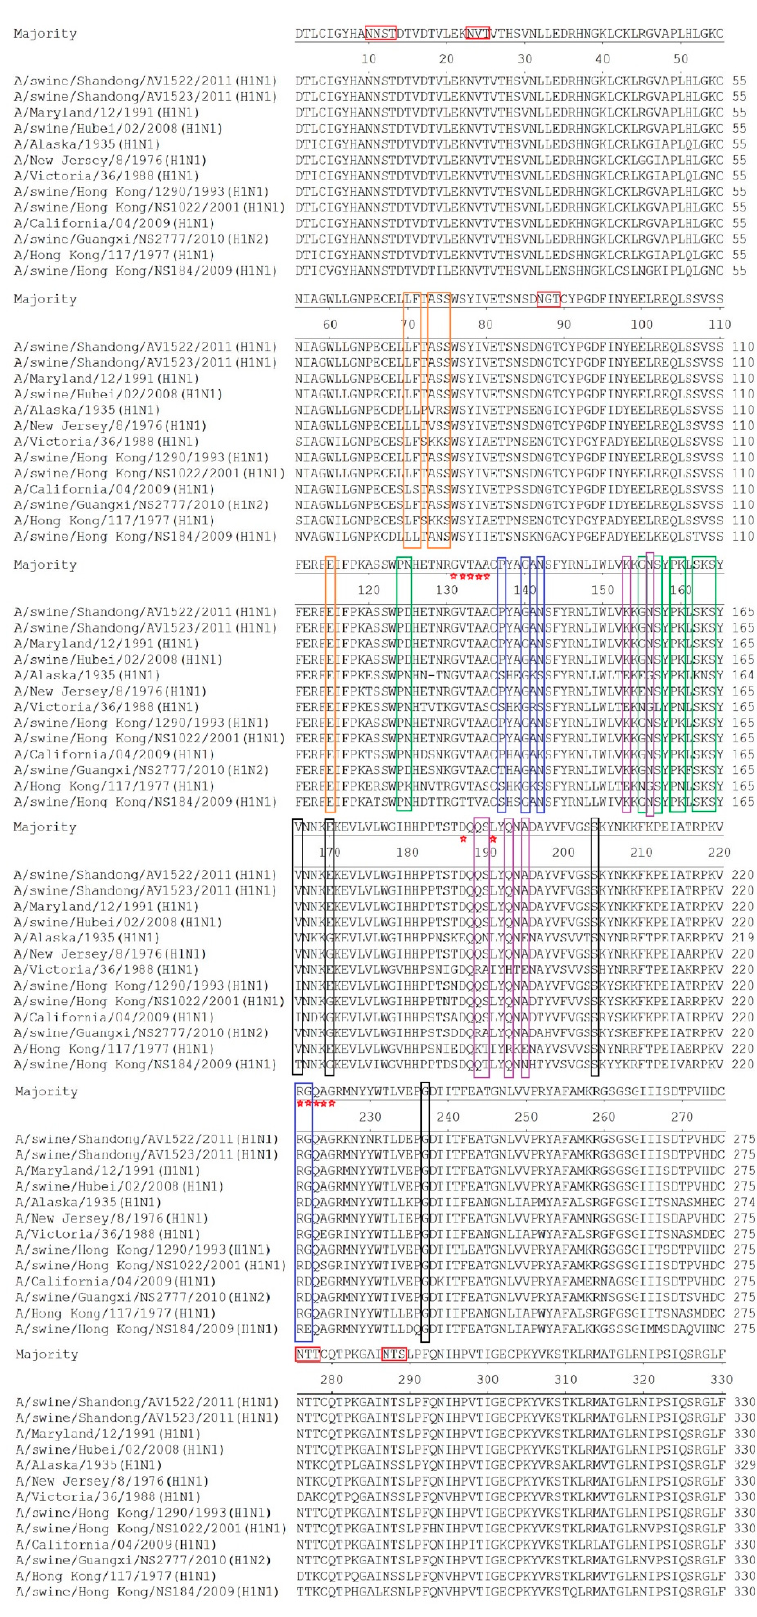
Figure 2. Molecular analysis of HA1 amino acid sequences of the two H1N1 swine influenza viruses and reference strains. Potential glycosylation sites were marked with red shade. Previously defined antigenic sites were indicated: Site Sa (green shade), site Sb (purple shade), site Ca1 (black shade), site Ca2 (blue shade), Cb (orange shade). The pentagram represents the receptor-binding sites. A/Maryland/12/1991(H1N1),